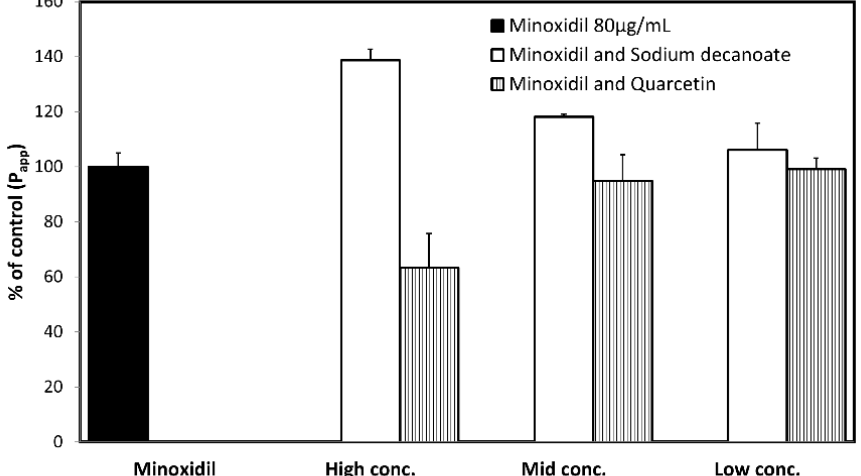
Figure 6. The percentage of control P app for minoxidil alone, and minoxidil with different concentra- tions of quercetin/sodium decanoate. Mean ± SD; n = 4.